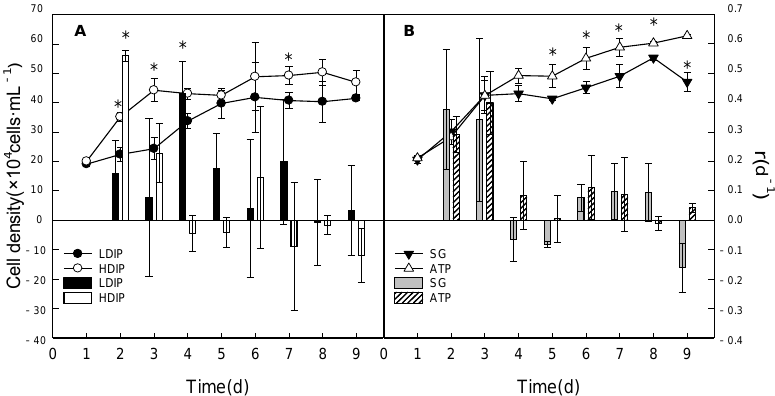
Figure 1. Variations in the cell density and growth rate (columns) of C. roscoffensis in groups of inorganic ( A ) and organic ( B ) initial phosphorus resources. (LDIP): low concentration of inorganic phosphorus; (HDIP): high concentration of inorganic phosphorus; (SG): Na 2 -glycerophosphate; (ATP): adenosine triphosphate. * statistical significance, p < 0.05.